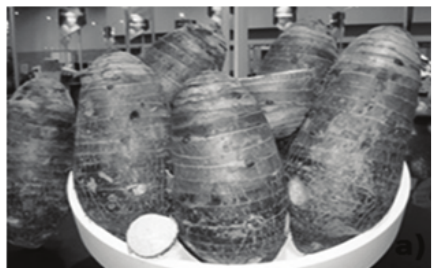
Figure 1: Colocasia antiquorum : taro coconut or Chinese